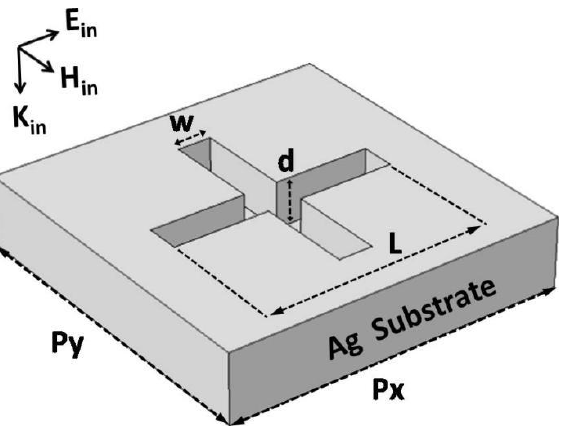
Figure 1. Schematic of the building block of metasurfaces for perfect absorption and refractive- index sensing. index